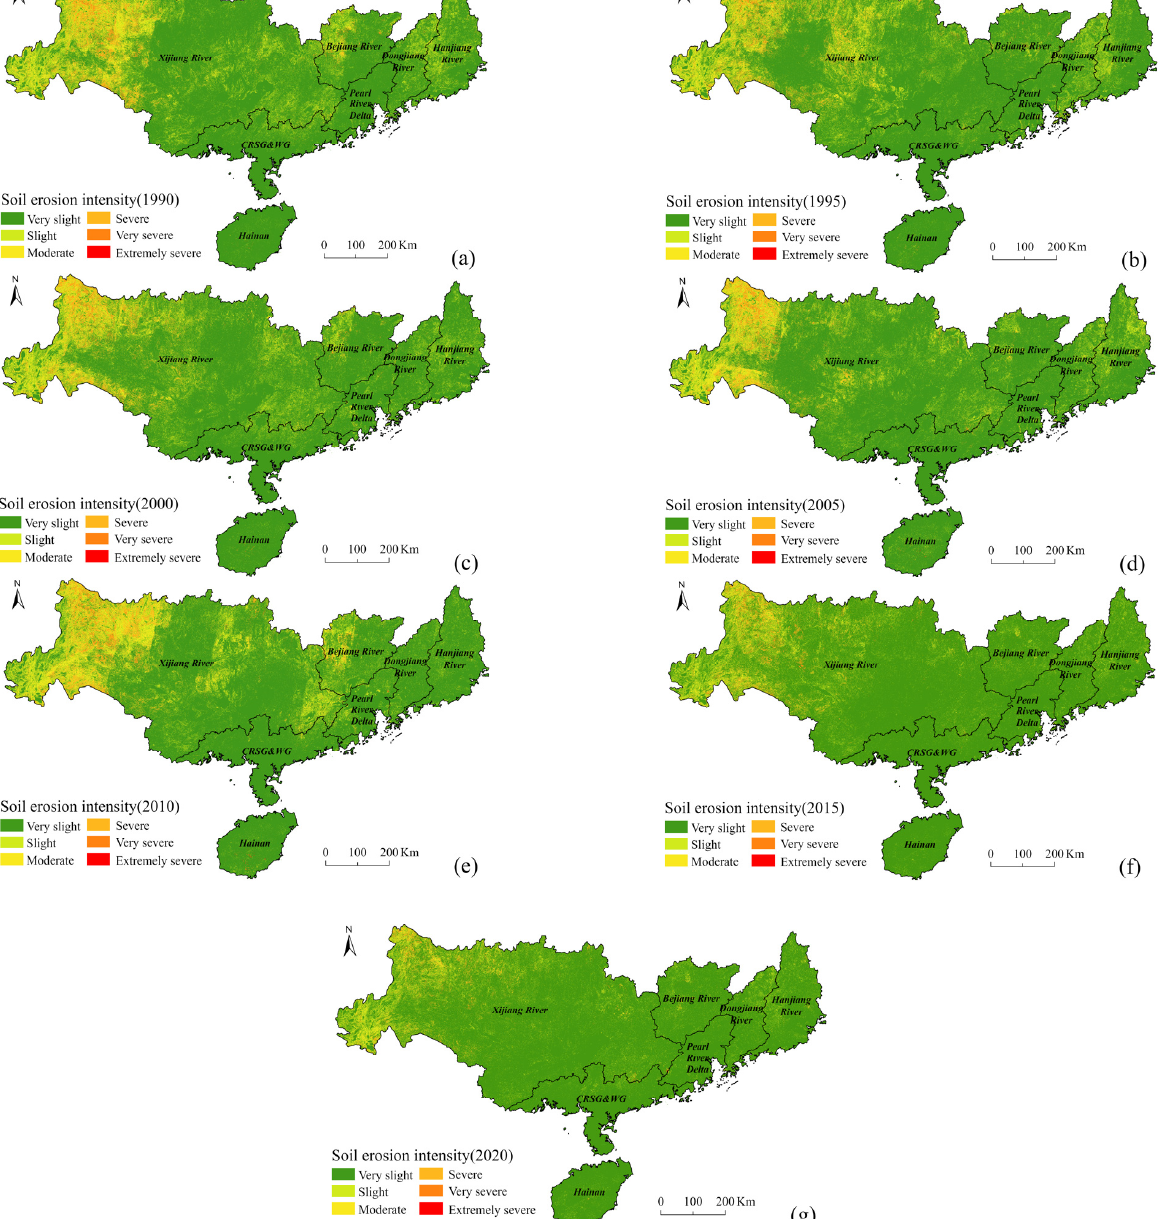
Figure 3. Spatiotemporal patterns of soil erosion in GPRB. According to the Chinese National Soil Erosion Classification Standard [62], soil erosion rate in the levels of very slight, slight, moderate, se- vere, very severe, and extremely severe are 0–500 t/(km 2 · a), 500–2500 t/(km 2 · a), 2500–5000 t/(km 2 · a), 5000–8000 t/(km 2 · a), 8000–15,000 t/(km 2 · a) and >15,000 t/(km 2 · a), ( a ) soil erosion intensity in